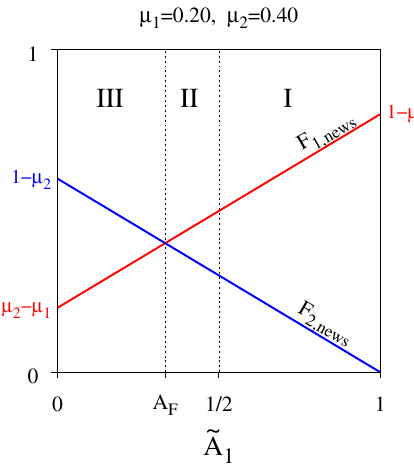
Fig. 1 We represent the share of the news of outlets 1 and 2. The red line corresponds to the fraction of news published by the low-standard outlet (with μ = 0 . 2) and the blue line to 1 the fraction of news published by the high-standard outlet (with μ = 0 . 4). The vertical lines at 2 A F (value of (cid:2) A 1 such that